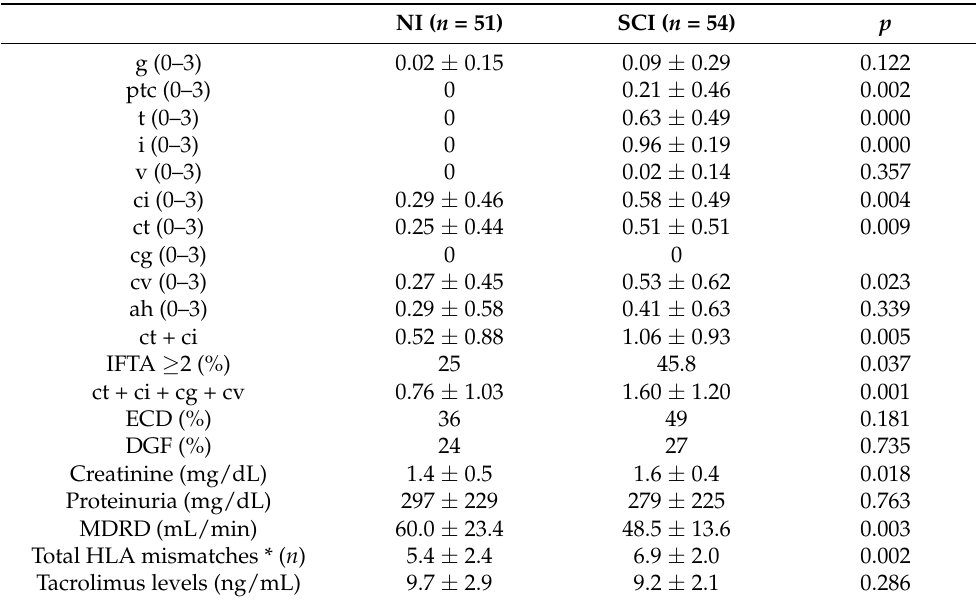
Table 4. Inflammatory and chronicity scores and clinical data in the NI and SCI groups at the baseline 3-month protocol